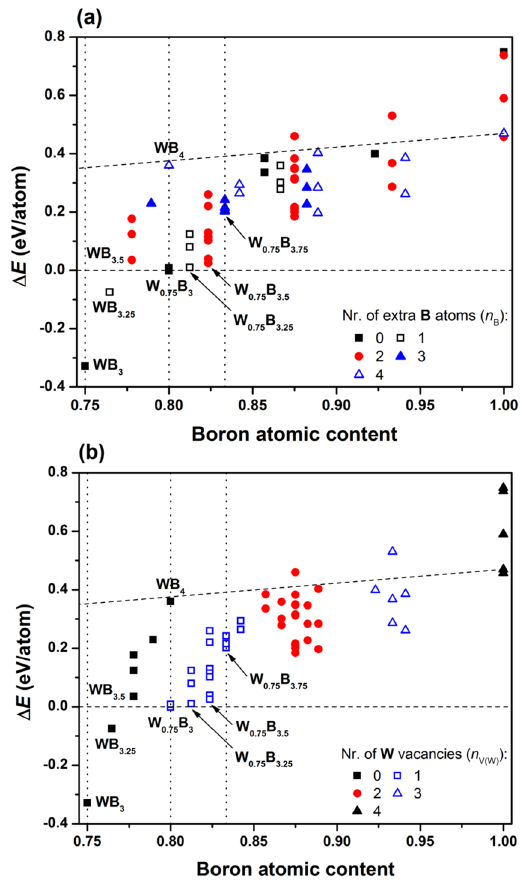
Figure 2. Enthalpies of formation for structures derived from hP 16-WB 3 by selective removal of tungsten atoms and/or contamination by additional boron atoms. ( a ) and ( b ) Show the same results organized in two different ways described in the text. The vertical dotted lines are drawn as guide to the eye and correspond to selective boron atomic contents. The horizontal dashed line and the line that is above represent cI 2-W ↔ hP 12-B and cI 2-W ↔ hP 16-B lines,